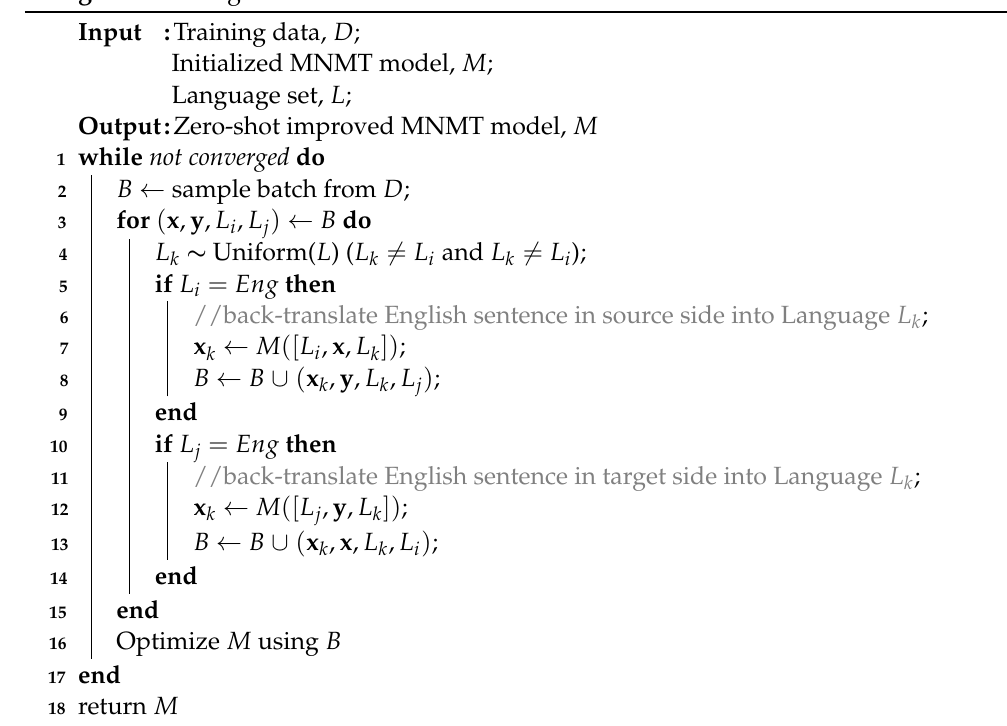
Algorithm 1: Algorithm for Pivot Online